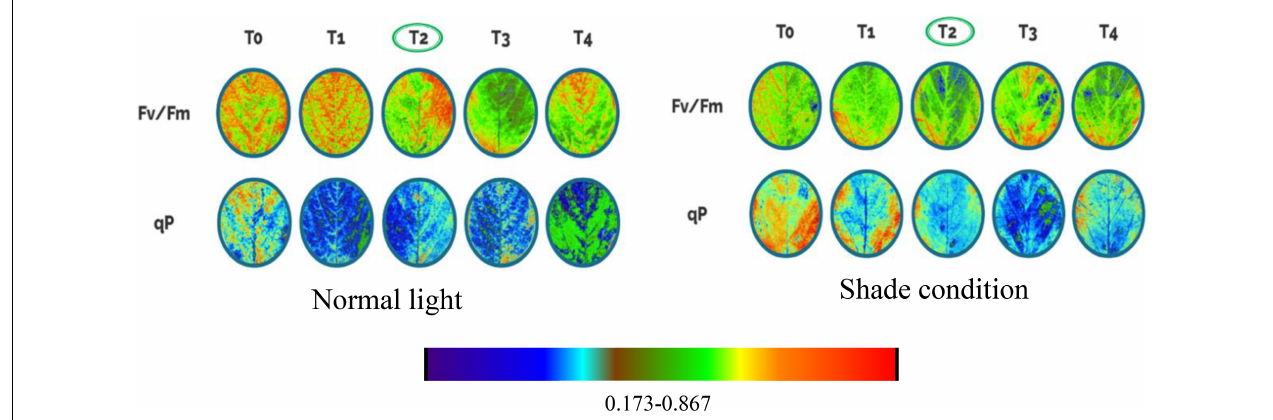
FIGURE 8 | Impact of foliar application NH 4 + /NO 3 − ratios on soybean photochemical efficiency under normal light and shade. Ratios of NH 4 + /NO 3 − (T0, T1, T2, T3, and T4) denote 0/0, 0/100, 25/75, 50/50, and 75/25, respectively.